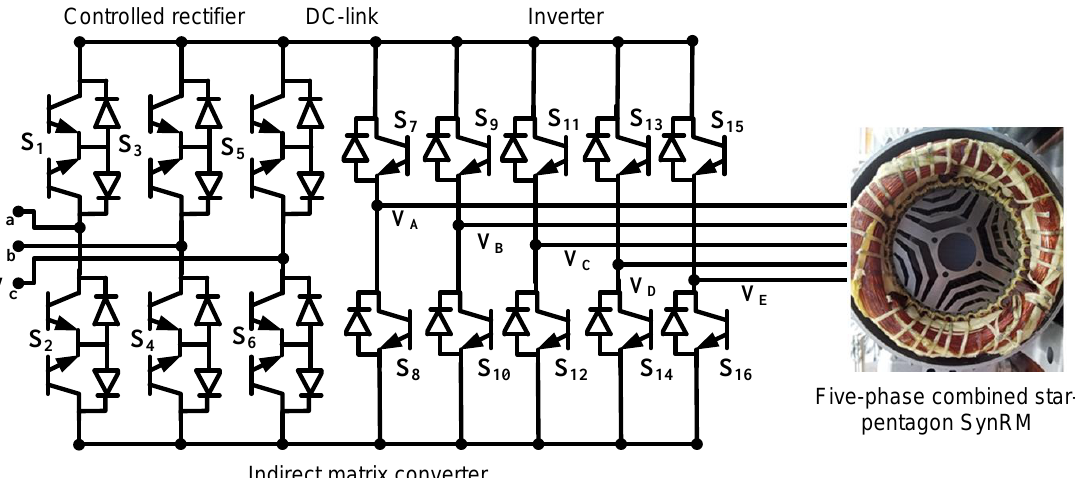
Figure 1. Five-phase SynRM drive system based on indirect MC.